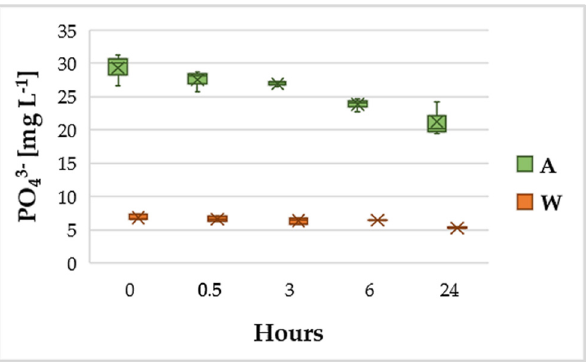
Figure 4. Variation of PO 43 − in the wastewater (W) and in the standard growth medium (A).